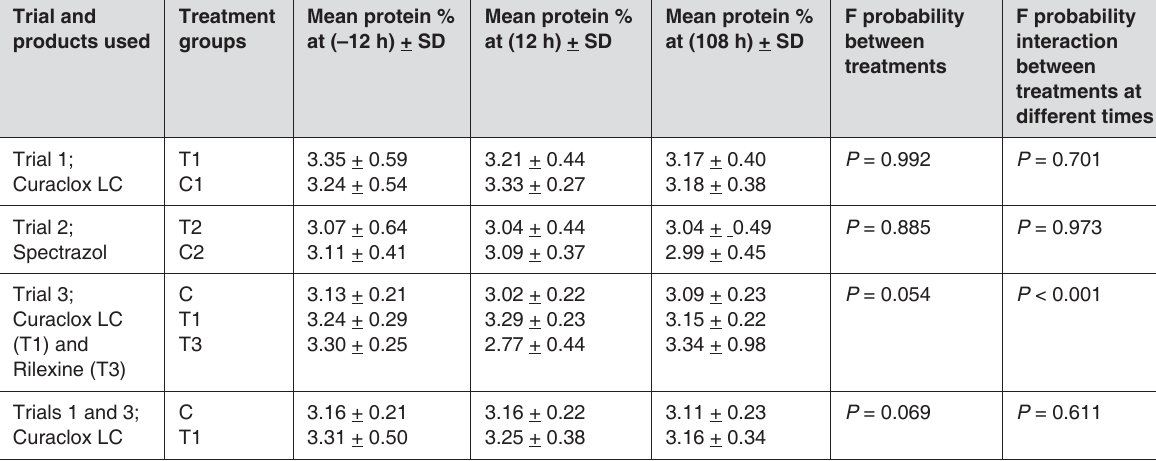
TABLE 4 Protein percentages of milk for treatment (T1, T2 and T3) and control groups of goats. (Analysis of an unbalanced design) Trial and products